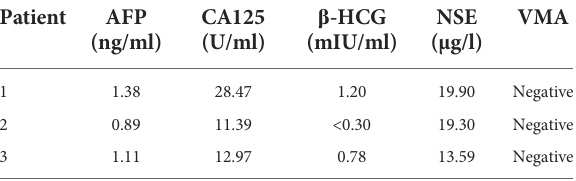
TABLE 1 Preoperative tumor markers of